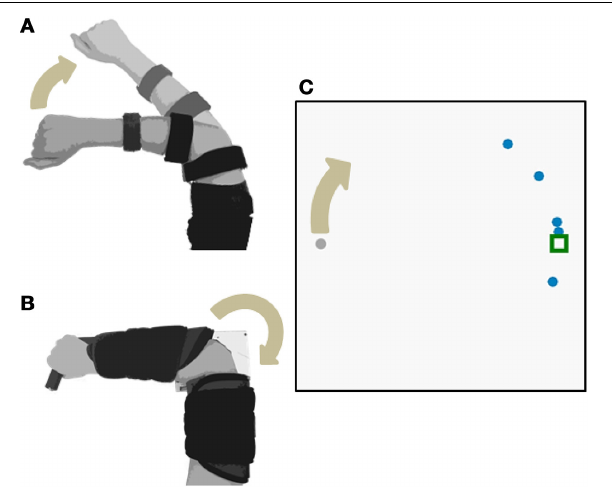
FIGURE 1 | Experimental Setup. Subjects used elbow extension to move a cursor with three different control interfaces: (A) joint angle and (B) joint torque and EMG. The joint angle control interface used isotonic contractions; joint torque and EMG control interfaces both used isometric contractions. The cursor moved along a 1-DOF circular track (C)